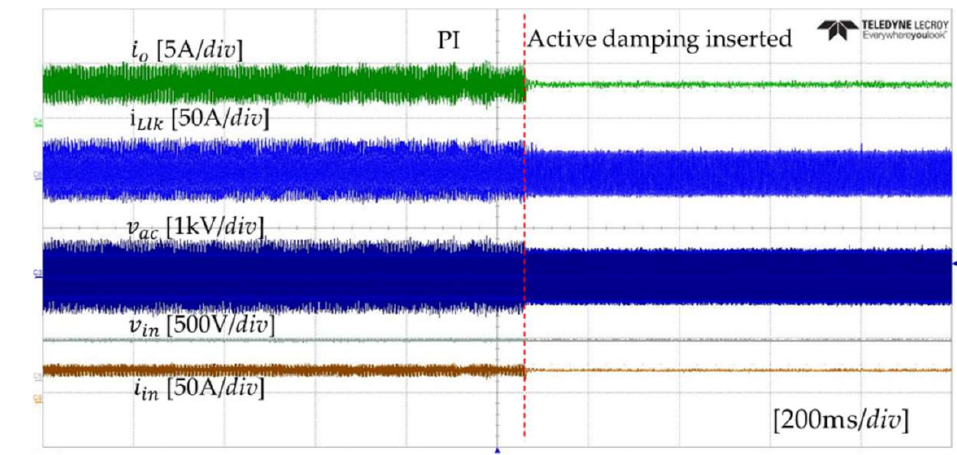
Figure 26. Experimental result of inserting active damping by proposed